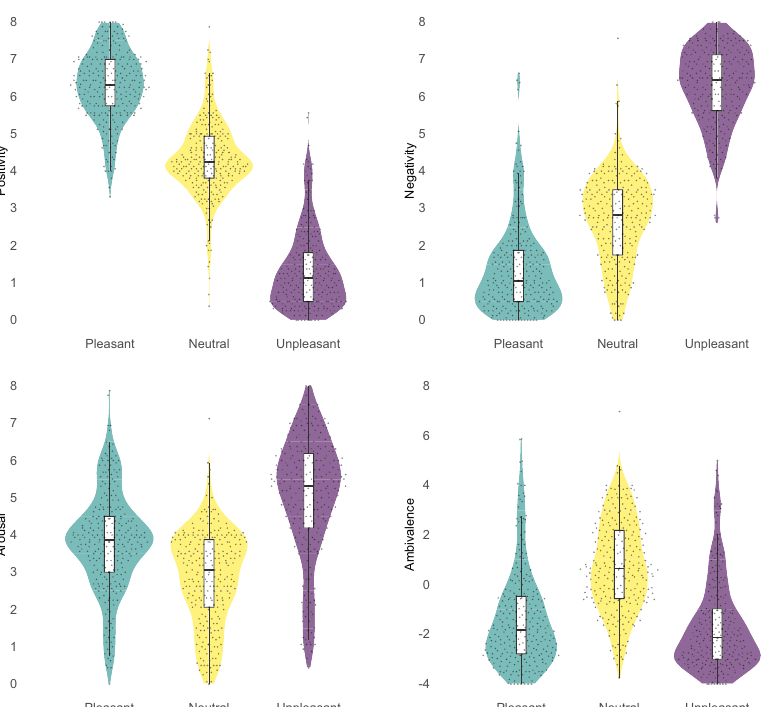
Fig. 1 Violin plots for raw emotional responses (positivity, negativity, arousal) and ambivalence with box-plots and superimposed individual participant data points. The box-plots illustrate the fi rst and third quartile (box limits), median (center line), and ±1.5 interquartile range (whiskers). Individual data points correspond to the mean response of each participant for the respective stimulus category and response